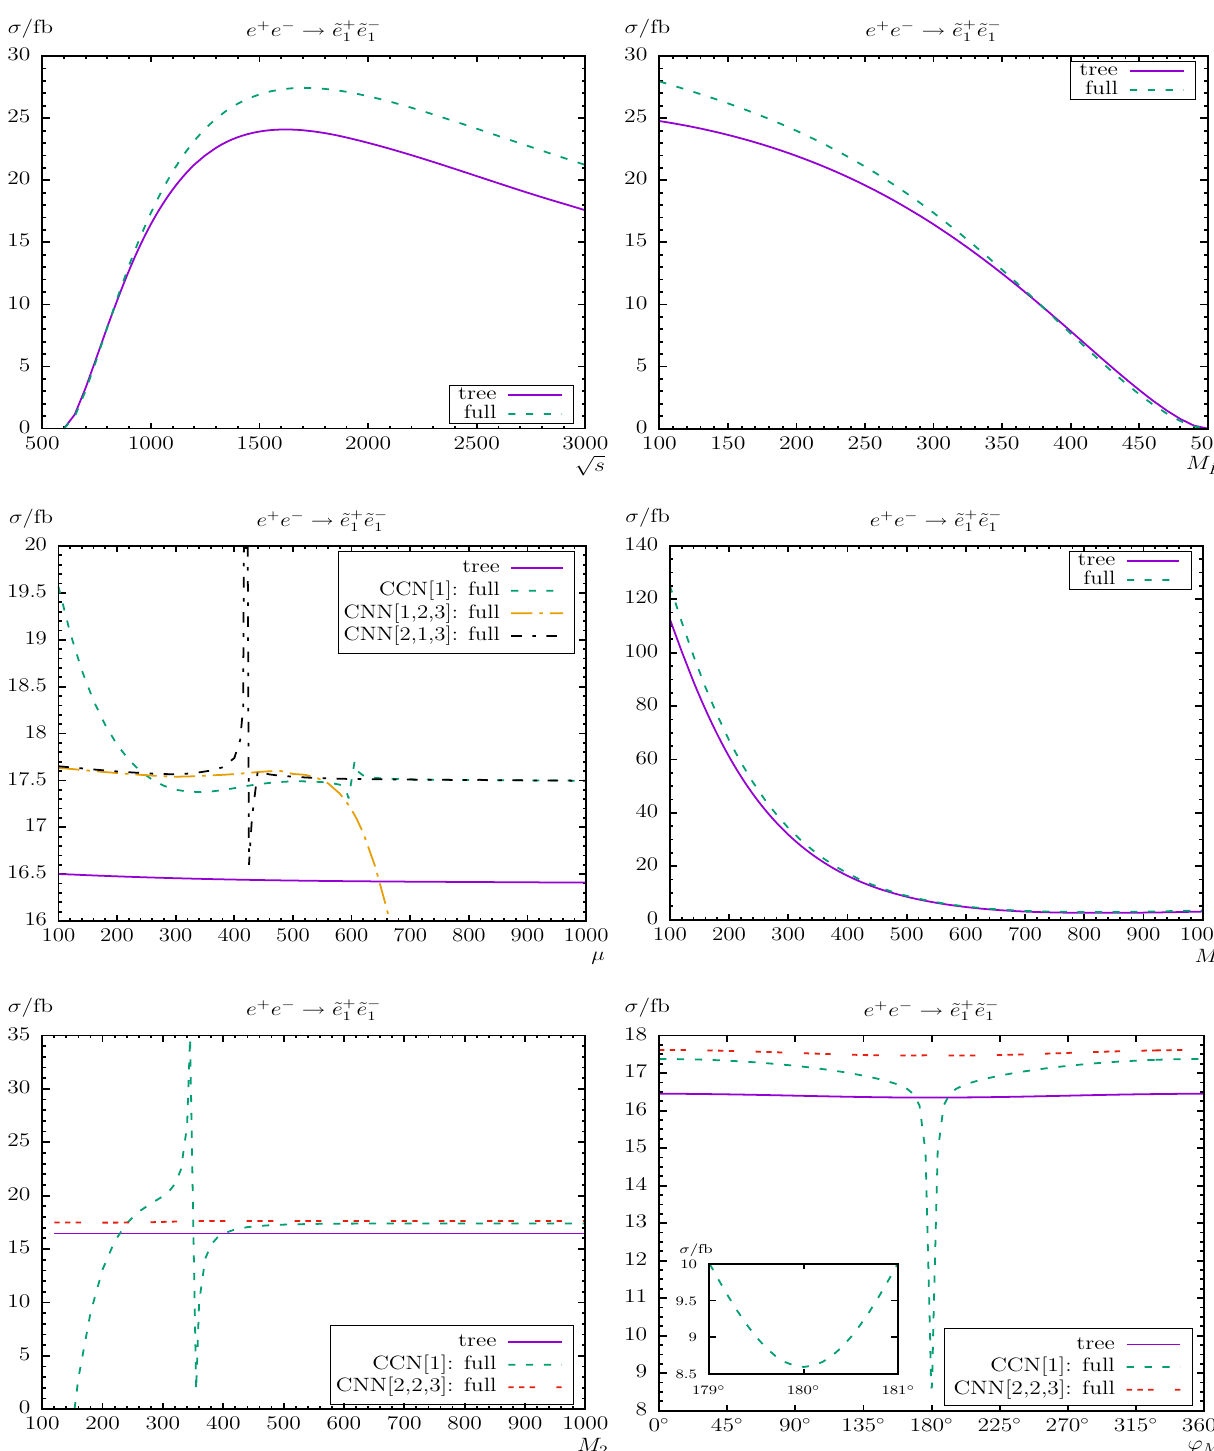
˜ e − ) .Tree-levelandfullone-loopcorrectedcross Fig. 9 σ( e + e − → ˜ e + varied; the middle plots show μ (left) and | M 1 | (right) varied; the lower 1 1 sections are shown with parameters chosen according to S ; see Table 1. plots show M 2 (left) and ϕ M √ s (left) and M ˜ The upper plots show the cross sections with are in (right) E